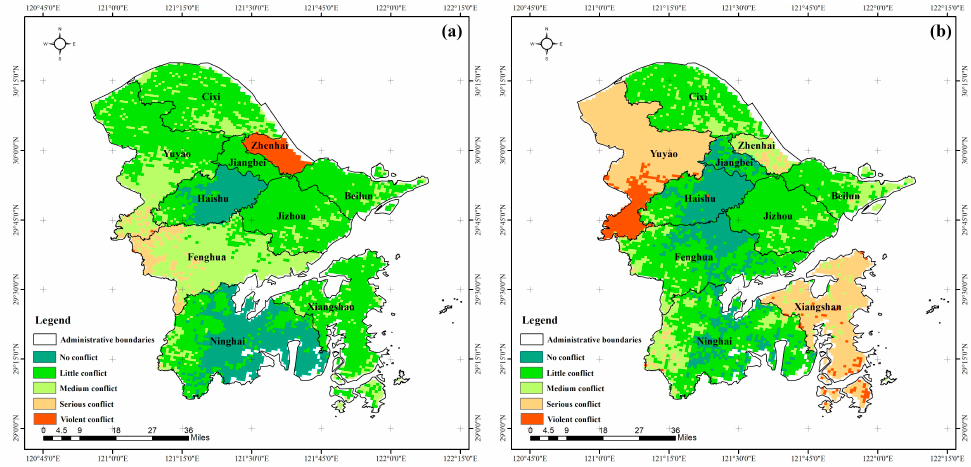
Figure 5. Multiscale PLES conflict identification in Ningbo for ( a ) 2010 and ( b )